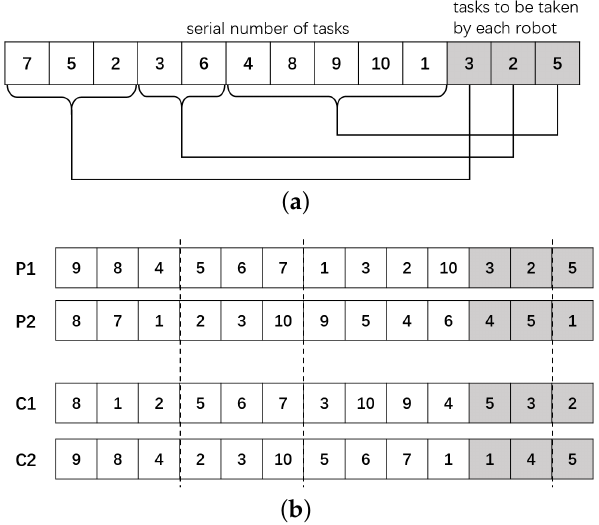
Figure 2. Example of ( a ) two-part chromosome representation and ( b ) crossover